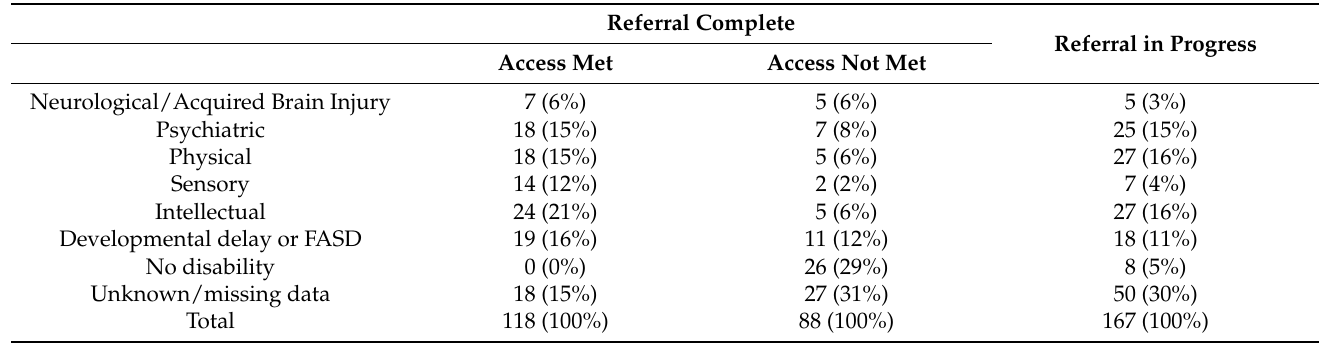
Table 2. Referrals to EACP by primary disability category and access status { n (%)}. Referral